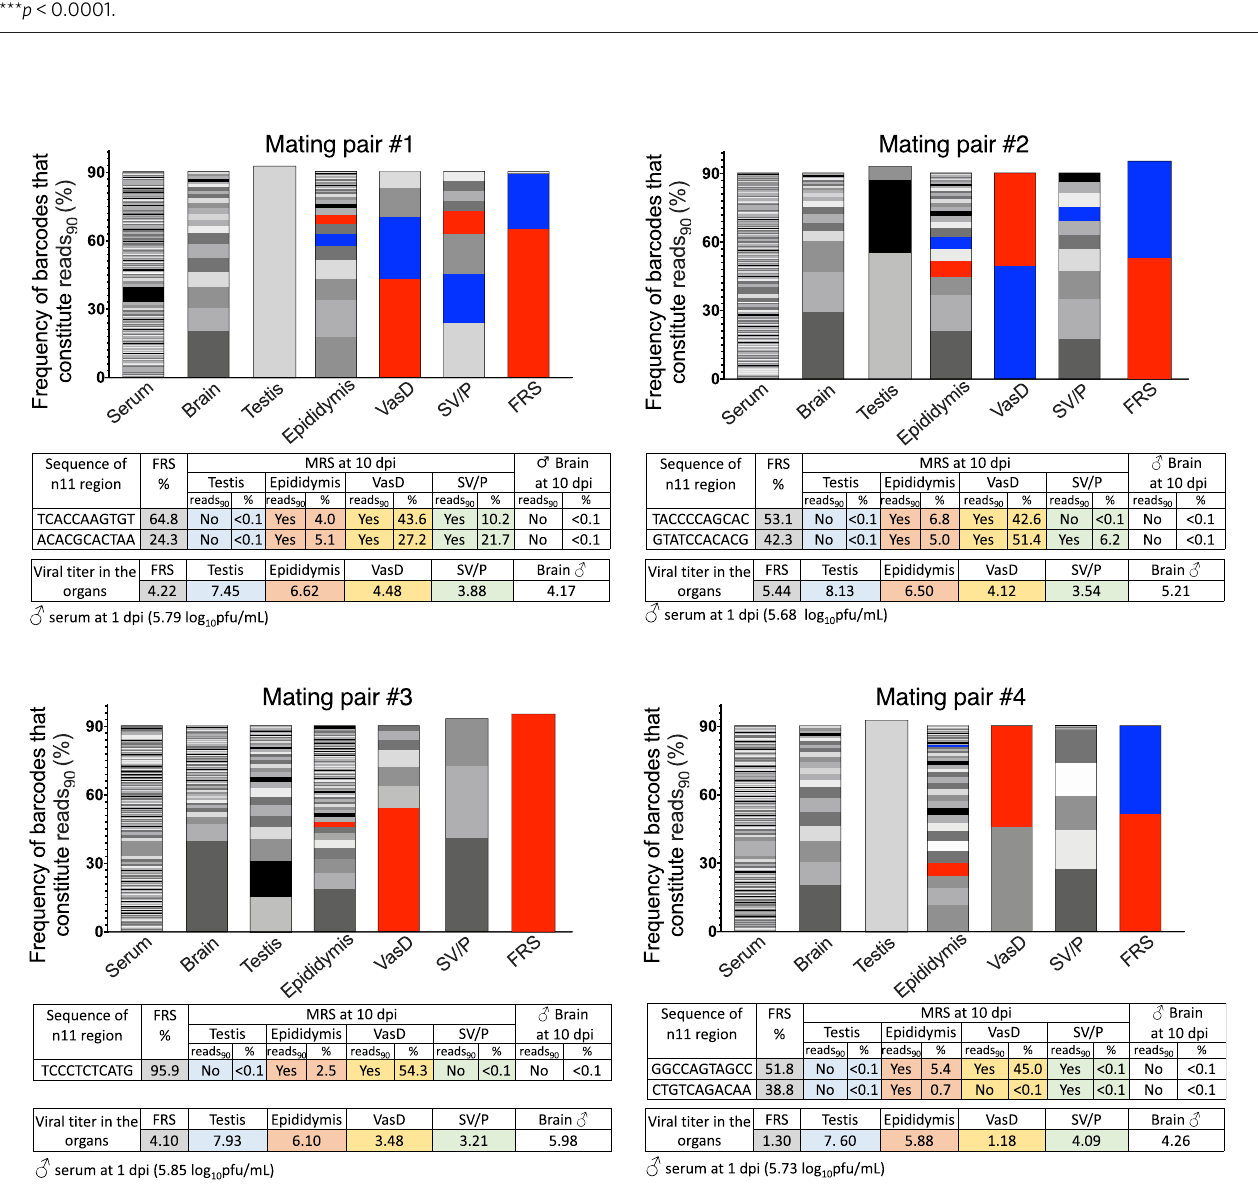
Fig. 6 Tracing individual ZIKV genomes during male to female ST of ZIKV-lib/n11 viruses. Four male AG129 mice infected with ZIKV-lib/n11 deposited ZIKV + ejaculate into FRS of CD-1 mice at 10 dpi (see Fig. 5b). For each mating pair, a top panel shows the frequency of barcodes that together constitute reads 90 for the individual male or female organ. Each color represents a unique barcode. Only barcodes with frequencies of >1% in the FRS are shown as blue or red colors. Sequences and frequencies of these barcodes are presented in the middle panels. “ Yes ” or “ No ” denote whether the barcodes were among the reads 90 for the given organ. Bottom panels for each mating pair show the titers of ZIKV-lib/n11 viruses in mouse organs collected at 10 dpi. Virus titers in the FRS (ejaculate), testis, SV/P, and brain of males are expressed as log 10 (pfu/g). Virus titers in the epididymis and vas deferens are expressed as log 10